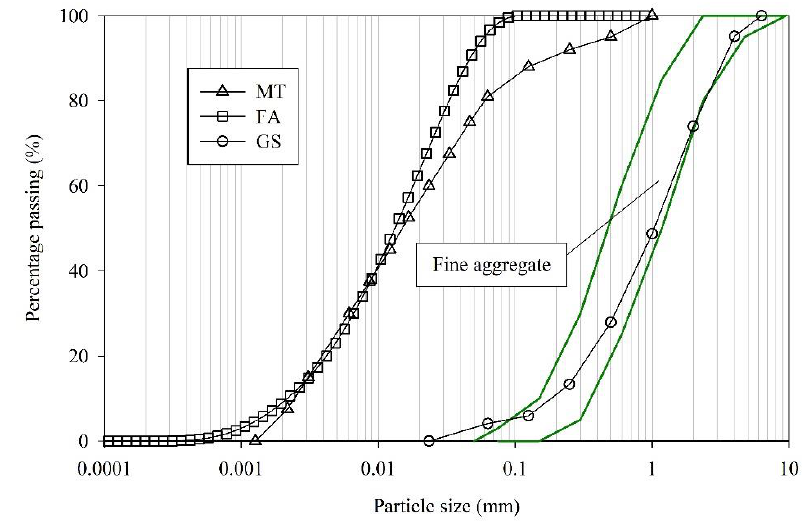
Figure 2. Particle size distribution.